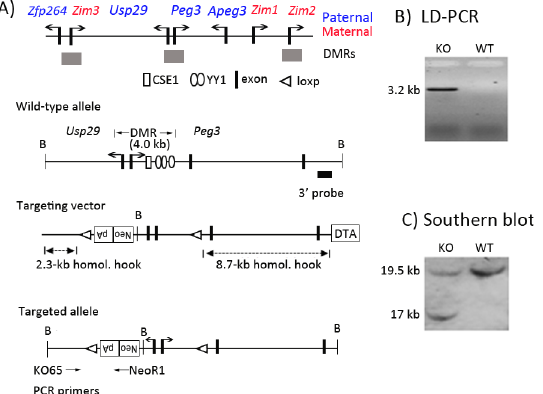
Fig 1. Peg3 domain and the targeting scheme. ( A ) Schematic representations of the Peg3 domain (upper panel). Each imprinted gene is indicated with an arrow. The genes with blue are paternally expressed whereas the genes with red are maternally expressed. The three DMRs are indicated with gray boxes. Targeting scheme (lower panel). The 4.0-kb Peg3-DMR contains the first exons of Peg3 and Usp29 and two evolutionarily conserved elements (CSE1 and CSE2 or YY1-binding site). The transcriptional direction of Peg3 and Usp29 is indicated with arrows, and exons are indicated with thick vertical lines. The region corresponding to the neomycin resistance gene ( NeoR ) along with the two flanking loxP sites within the targeting vector are also indicated by an open box and triangles, respectively. Arrows underneath ‘ Targeted allele ’ indicate primers with relative positions that were used for long-distance PCR. ( B ) LD (Long Distance)- PCR. A set of primers, KO65 and NeoR1, successfully amplified the 5.2-kb genomic fragment from the genomic DNA of a heterozygote animal (KO), but not from that of a wild-type littermate (WT), confirming the proper targeting of the KO construct. ( C ) Southern blot analyses on the DNA isolated from ES cells that had been transfected with the targeting vector. BamH I-digested DNA was hybridized with the 3 0 -side probe, showing an additional 17-kb fragment in a targeted clone.